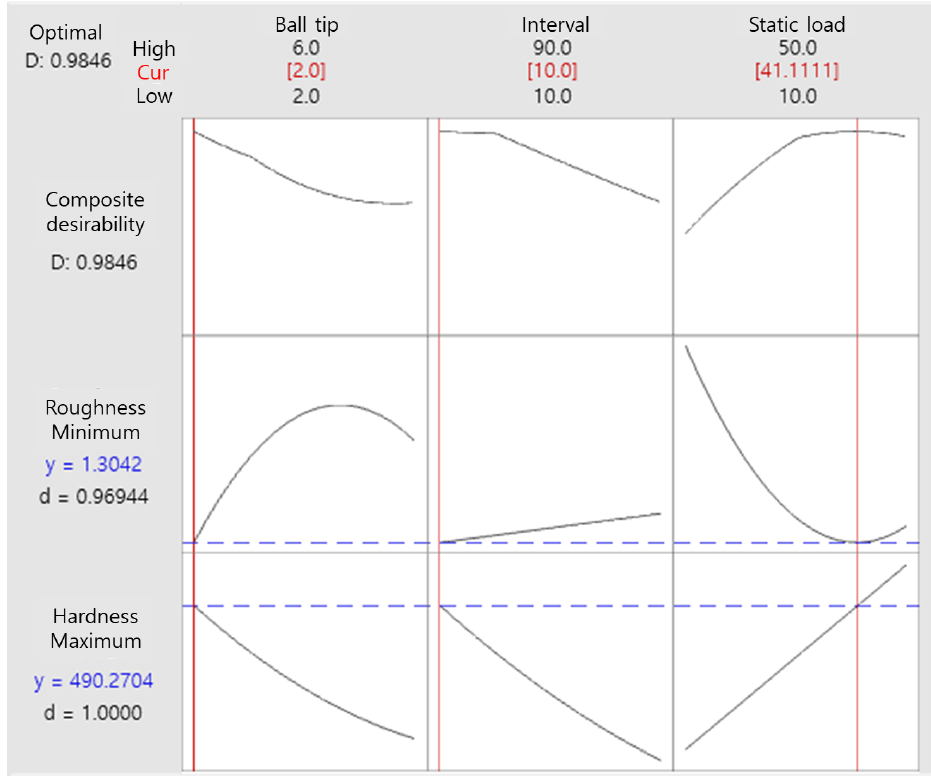
Figure 9. Results of multi-objective optimization of surface roughness and